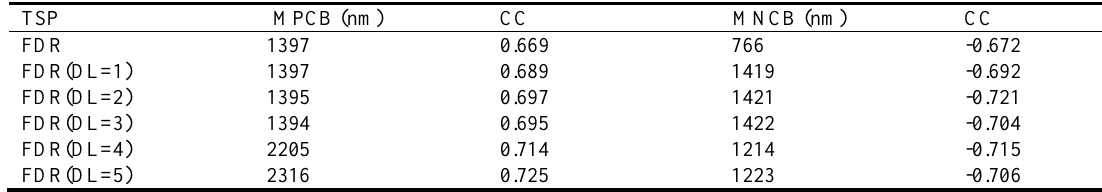
Table 1. Correlation analysis between total soil nitrogen (TN) and the first derivative differential FDR (initial and decomposed).